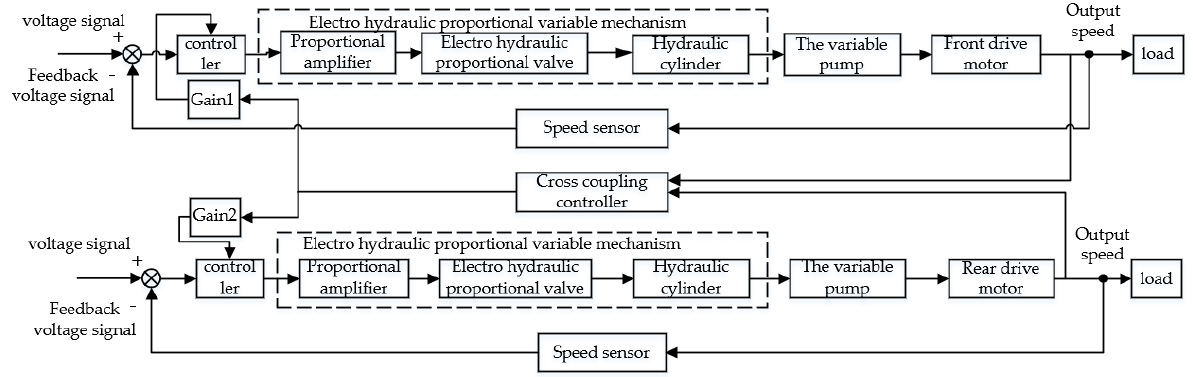
Figure 2. Speed regulation principle of hydrostatic travel system.